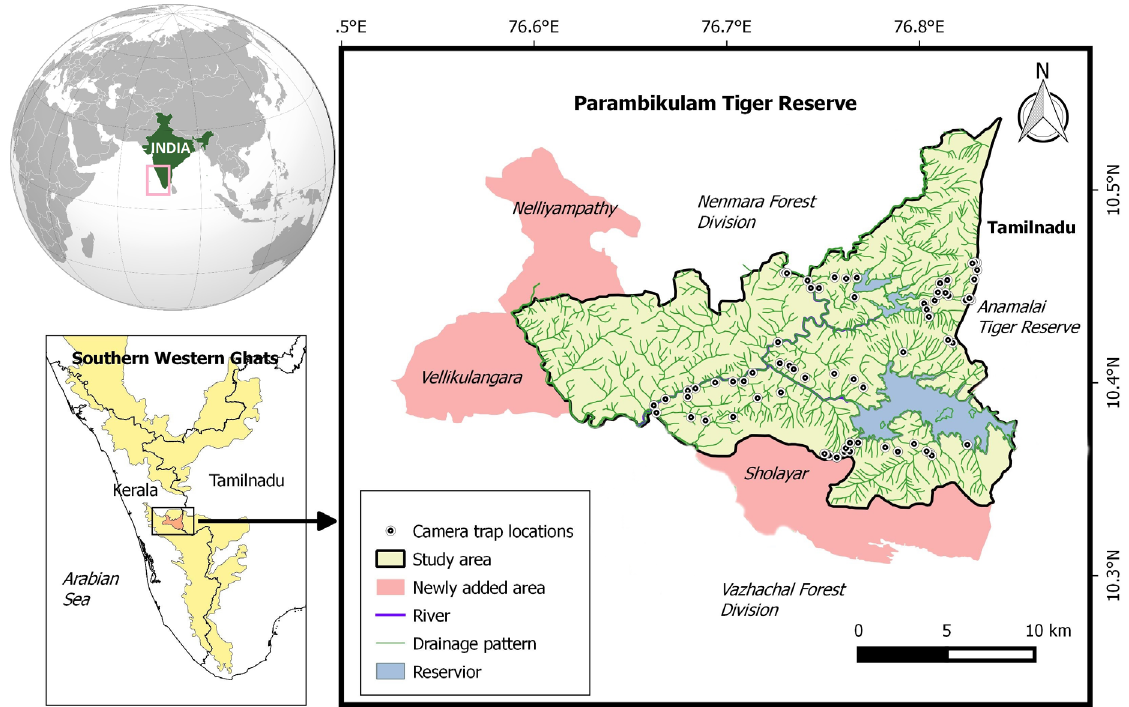
Figure 1. Location map of Parambikulam Tiger Reserve with Camera trap